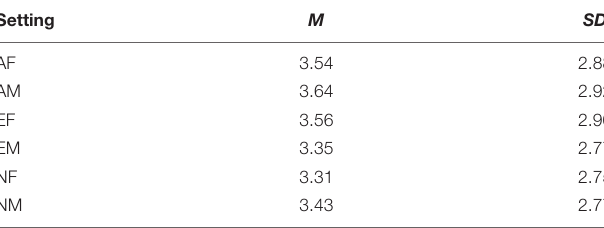
TABLE 2 | Mean ( M ) and standard deviation (SD), and 95.0% confidence interval